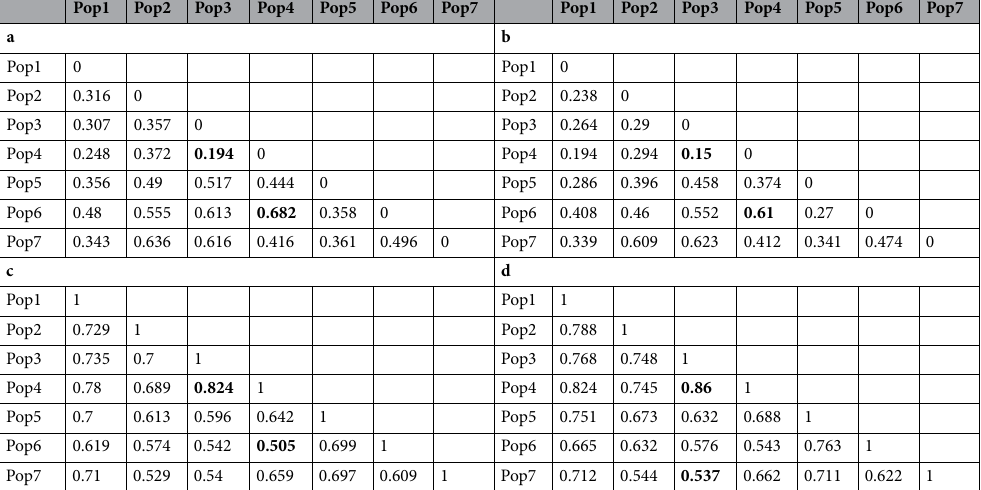
Table 5. Genetic Diversity Indices analyzed in S. wightiana populations; Pairwise Population Matrix of (a) Nei’s Genetic Distance, (b) Nei’s Unbiased Genetic Distance, (c) Nei’s Genetic Identity and (d) Nei’s Unbiased Genetic Identity. Maximum and minimum values for different diversity indices; a, b, c, and d are highlighted in bold.